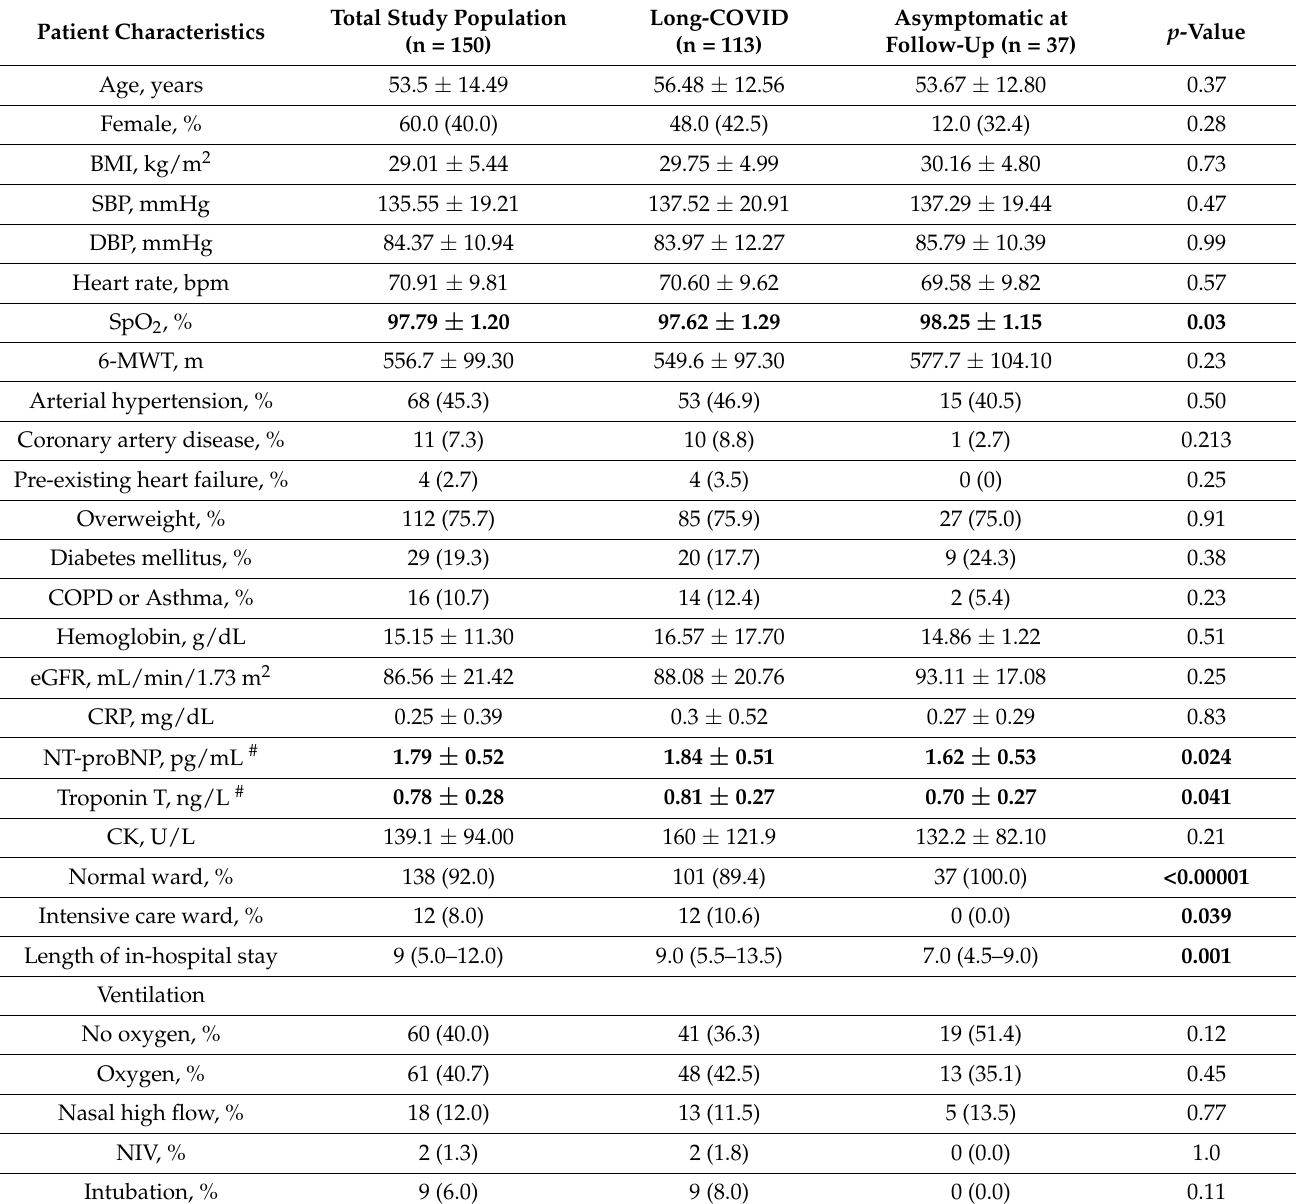
Table 1. Patient characteristics 6 months post discharge and details of in-hospital stay of 150 patients analyzed as total study population and according to